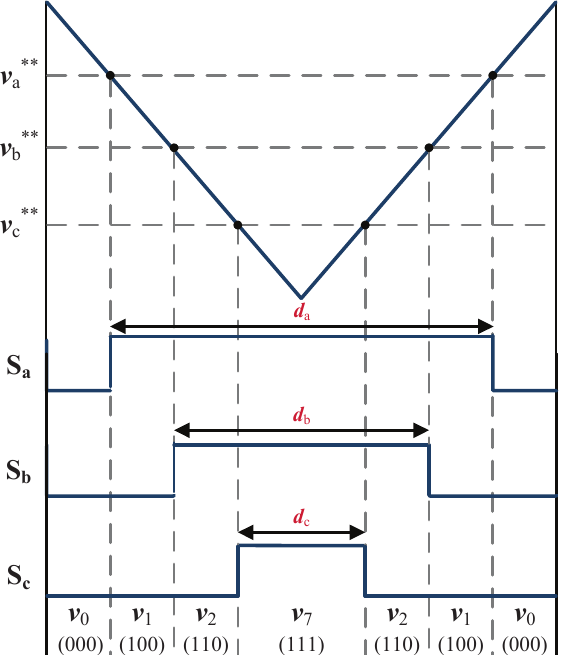
Figure 3. Three-phase duty cycles and vector duration in the sector